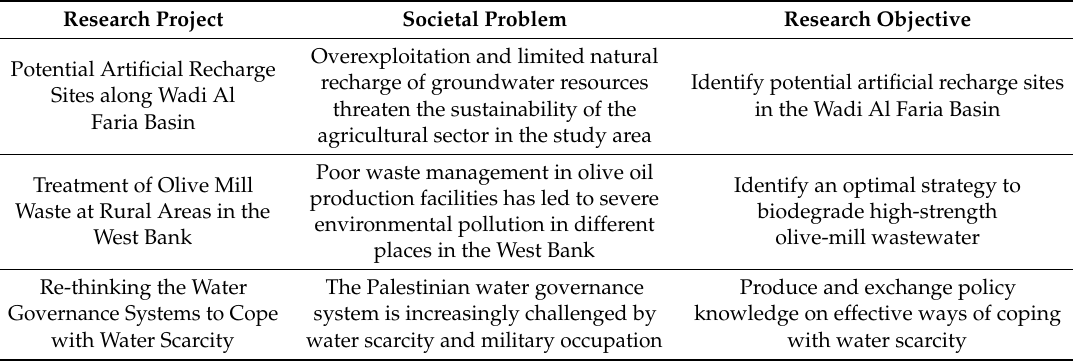
Table 6. Societal problem and research objective identified in each project